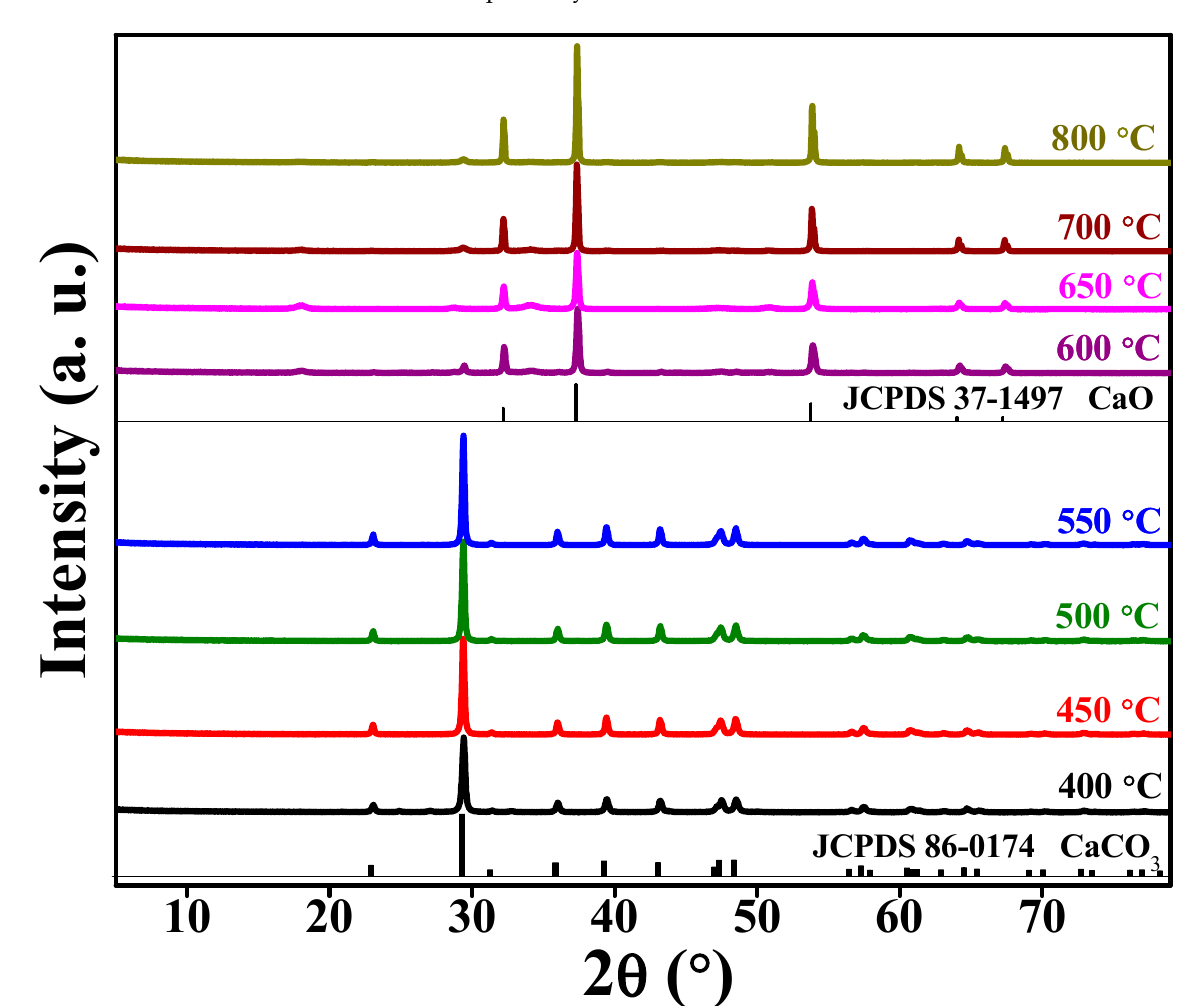
Figure 1. XRD patterns of CCNPs and CONPs fabricated from calcium oleate at different carbonization/calcination temperatures.